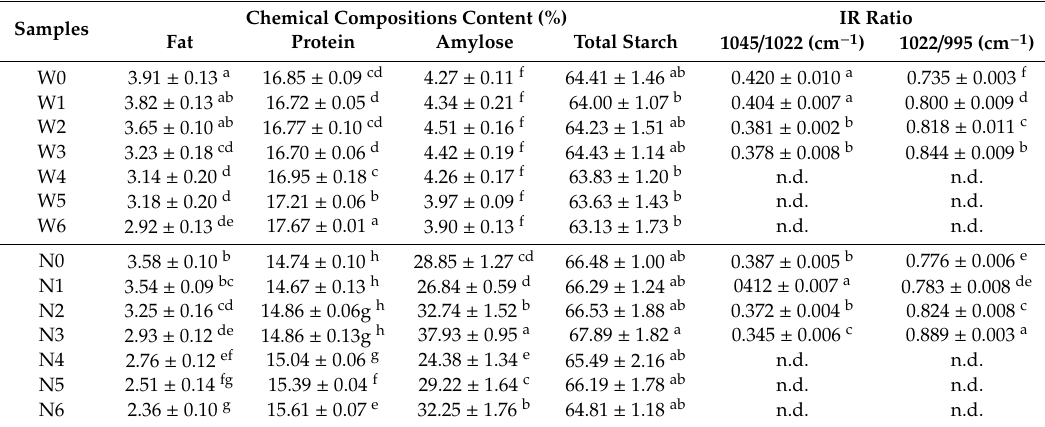
Table 1. Chemical compositions and IR ratio of uncooked and cooked flours.